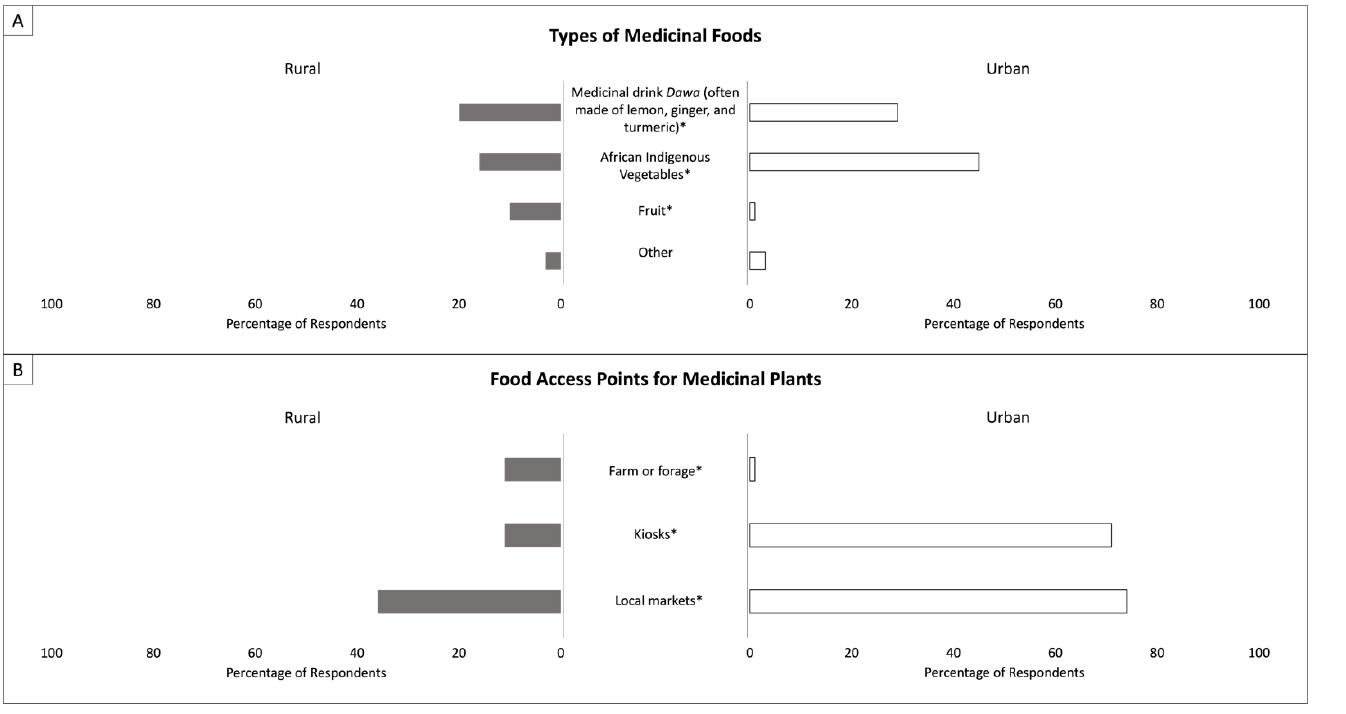
Figure 5. Types and access points of medicinal foods in urban ( n = 144) and rural ( n = 173) Kenya. * Statistically significant at p < 0.05 ( χ 2 test). ( A ) Types of medicinal foods consumed during the COVID-19 pandemic. Multiple responses were recorded. ( B ) Food access points for medicinal foods.